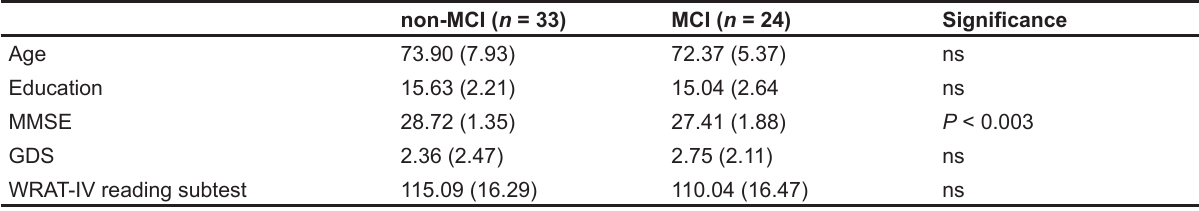
Table 2. Demographic and clinical information